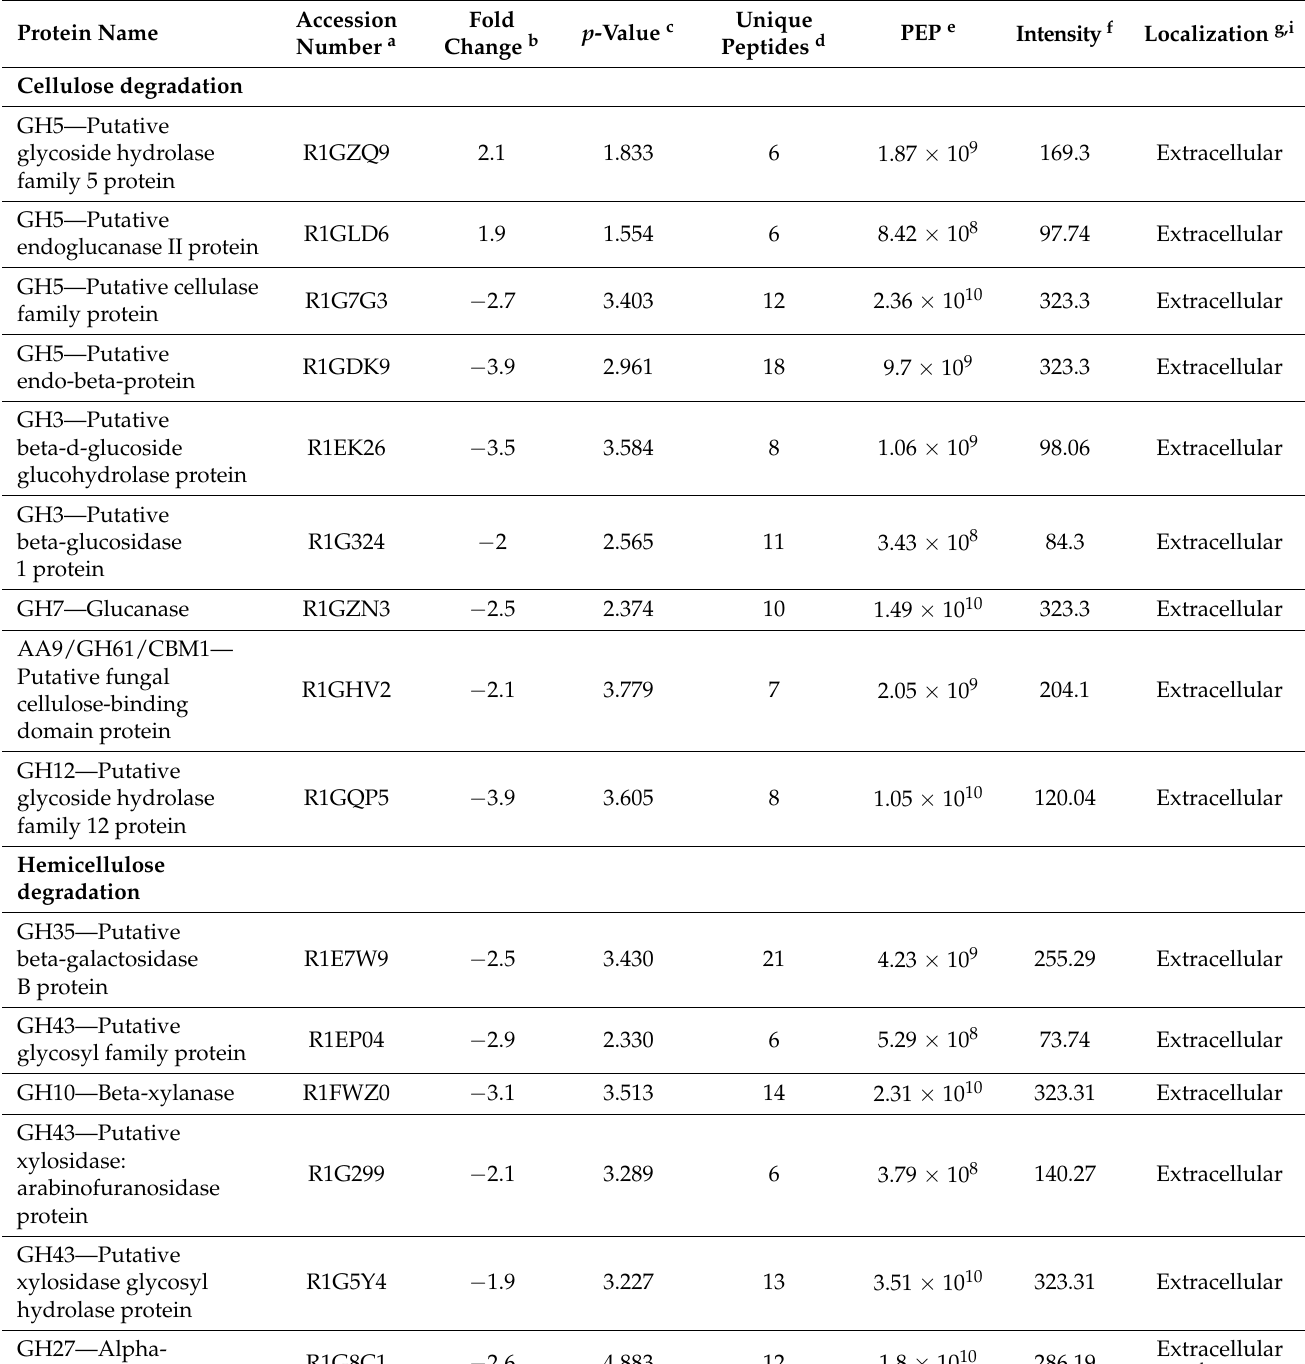
Table 2. Summary of the proteins differentially secreted by Neofusicoccum parvum (CAA704). Protein localization was predicted using SignalP [52], SecretomeP 2.0 [46], and BaCeILO [44]